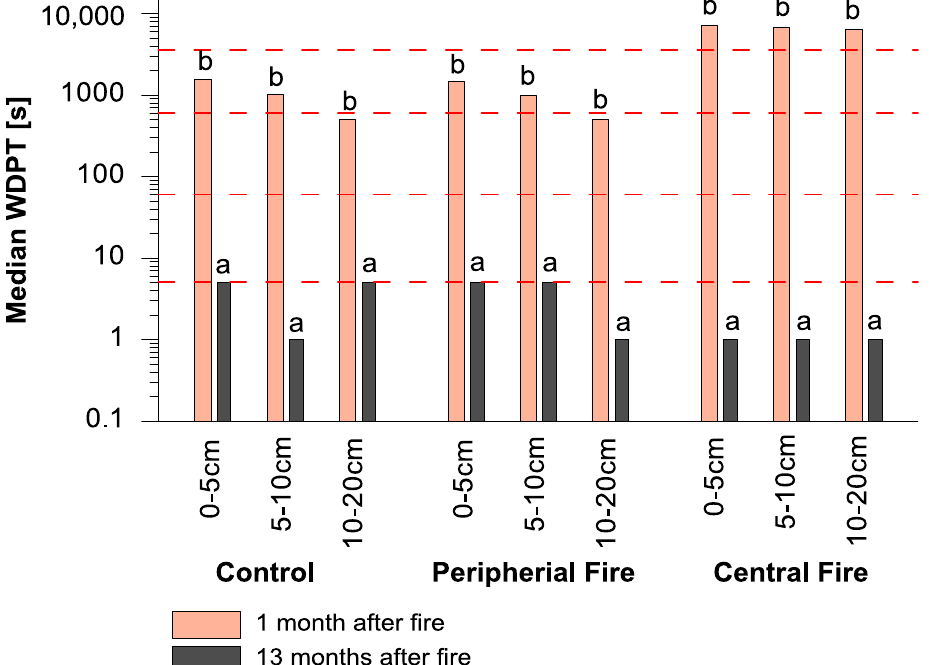
Figure 3. Median WDPT values of 0–5 cm, 5–10 cm, and 10–20 cm soil samples of control site, peripheral fire site, and central fire site, 1 month and 13 months after the fire. The different letters denote significant differences in the sampling period, as determined by the Mann-Whitney test (α < 0.01). The dashed lines denote SWR classes.